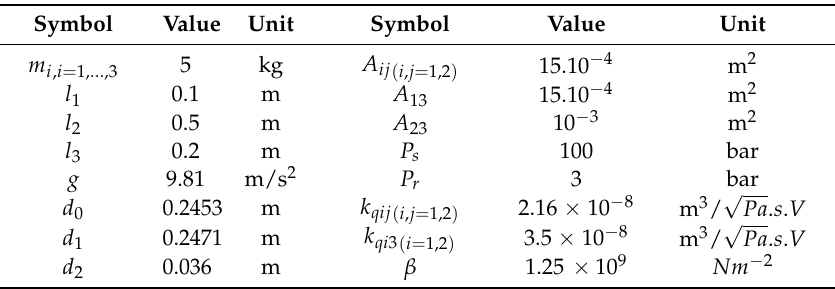
Table 1. Parameters of the hydraulic